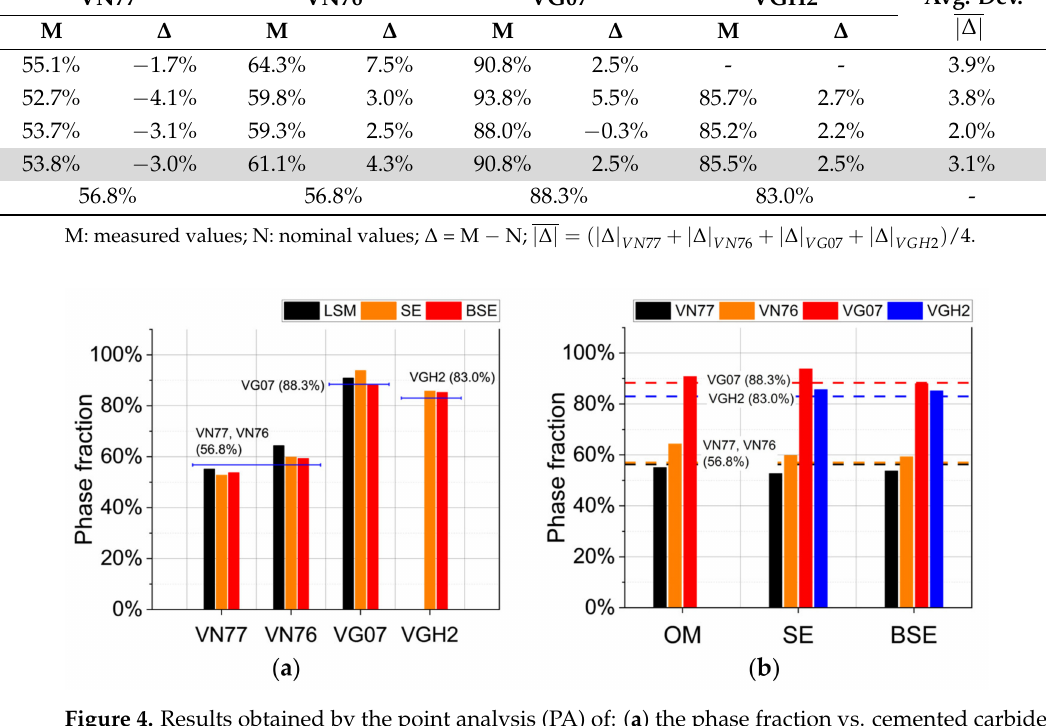
Figure 4. Results obtained by the point analysis (PA) of: ( a ) the phase fraction vs. cemented carbide grades, and ( b ) the phase fraction vs. image